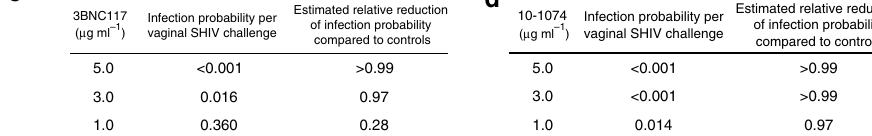
Fig. 4 Antibody concentration predicts the probability of infection following vaginal SHIV AD8-EO challenge. Probit regression analysis was used to estimate the per-challenge probability of vaginal SHIV acquisition as a function of imputed 3BNC117 concentrations in plasma among macaques that were administered 3BNC117 singly ( a ) or 10 – 1074 concentrations in plasma among animals that received 10 – 1074 in combination with 3BNC117 ( b ). The per- challenge probability of infection among untreated control animals was 0.50 and is denoted in blue. Tick marks represent SHIV challenge events that either did (red) or did not (green) result in systemic infection. The solid black or gray line is the model-based prediction; dashed black lines depict 90% pointwise con fi dence intervals. Model-based estimates of SHIV infection probabilities following a single vaginal SHIV challenge at the indicated plasma concentrations of 3BNC117 ( c ) or 10 – 1074 ( d